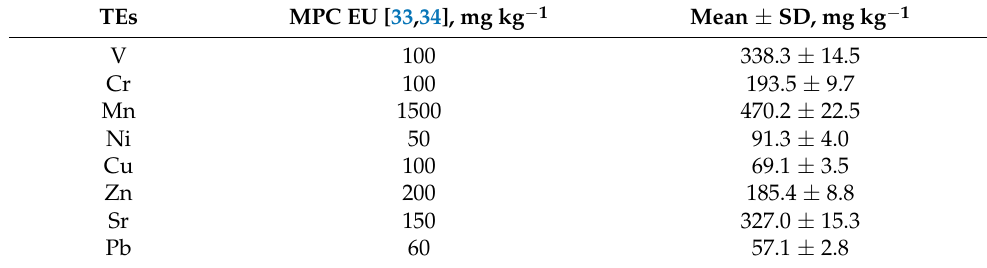
Table 2. TEs’ concentrations in the research soil; depth of soil sampling: 0–30